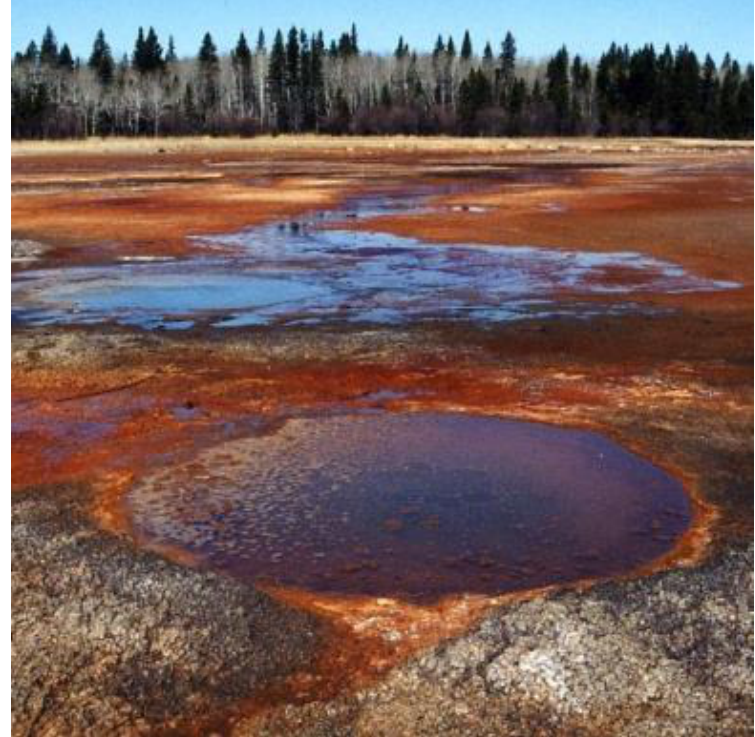
Figure 3. East German Creek hypersaline system, Manitoba, Canada. (Archives of V. Yurkov laboratory. Used with permission).